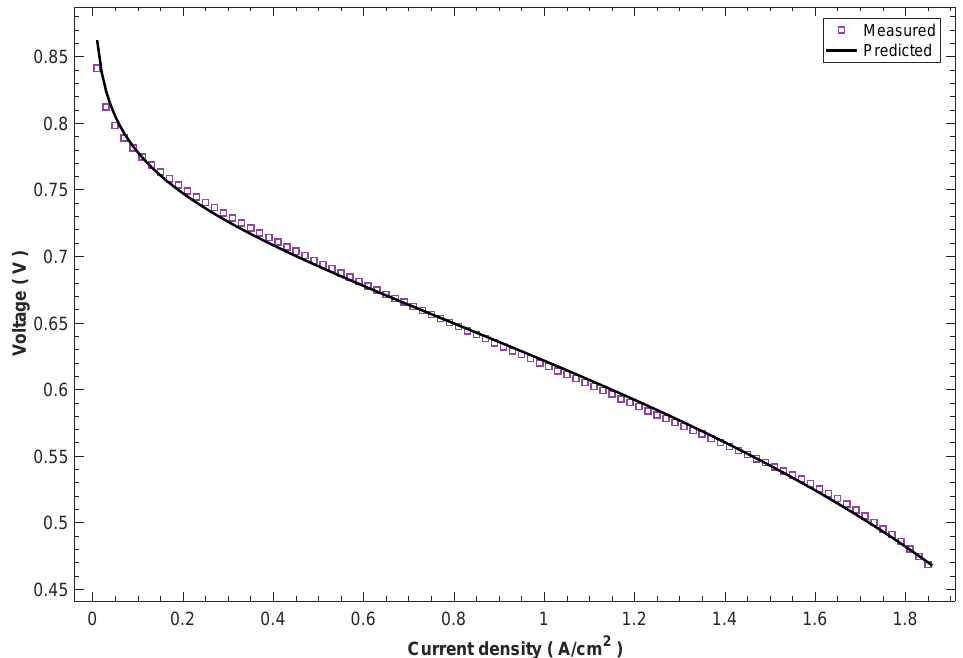
Figure 9. Modeled polarization curve using the computed unknown parameters through NNA, at 100%